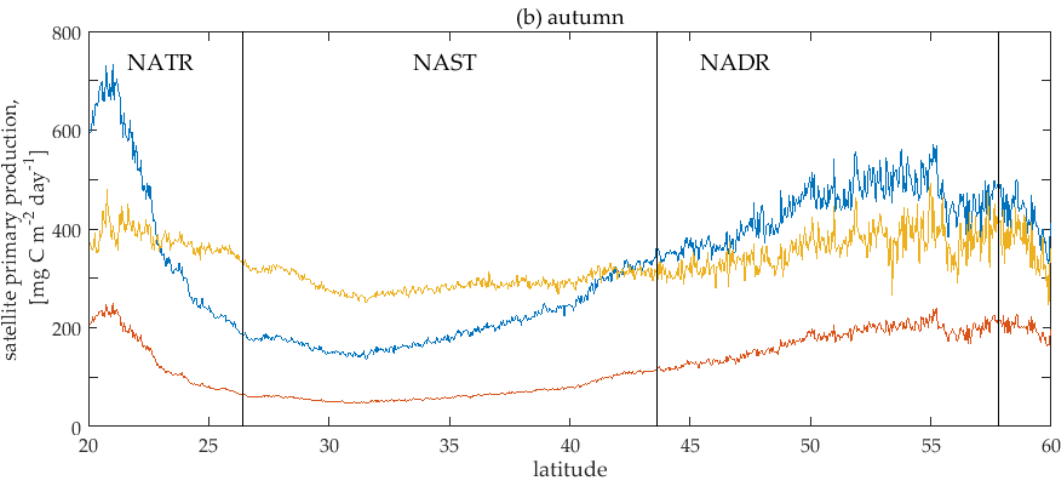
Figure 7. Spatial transects of satellite PP VGPM , PP PSM , and PP Aph (mg C m − 2 day − 1 ) along 20 °W from 20 to 60 ° N for ( a ) summer (June – August) and ( b ) autumn (September – November) using OC-CCI climatology for 1998–2011.